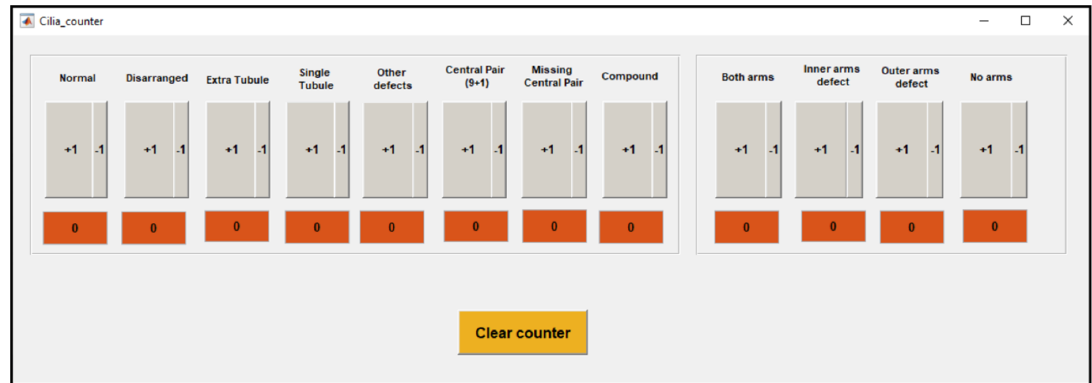
Figure 4. Basic digital counter to count cilia features to assist in the diagnosis of PCD.